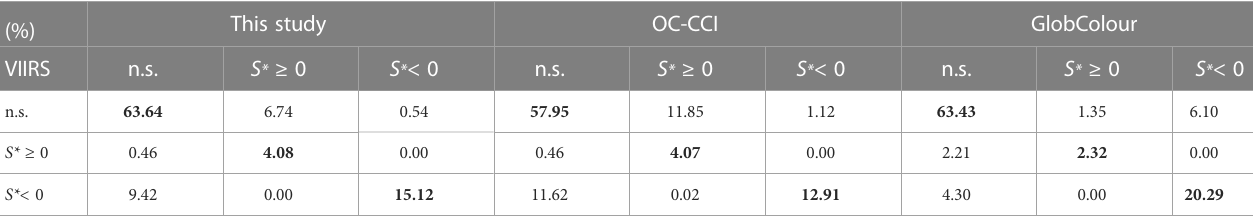
TABLE 3 Contingency matrices comparing trend analysis outcomes for VIIRS period.